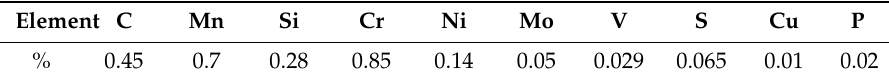
Table 1. The chemical composition of AISI 5140 carbon steel.